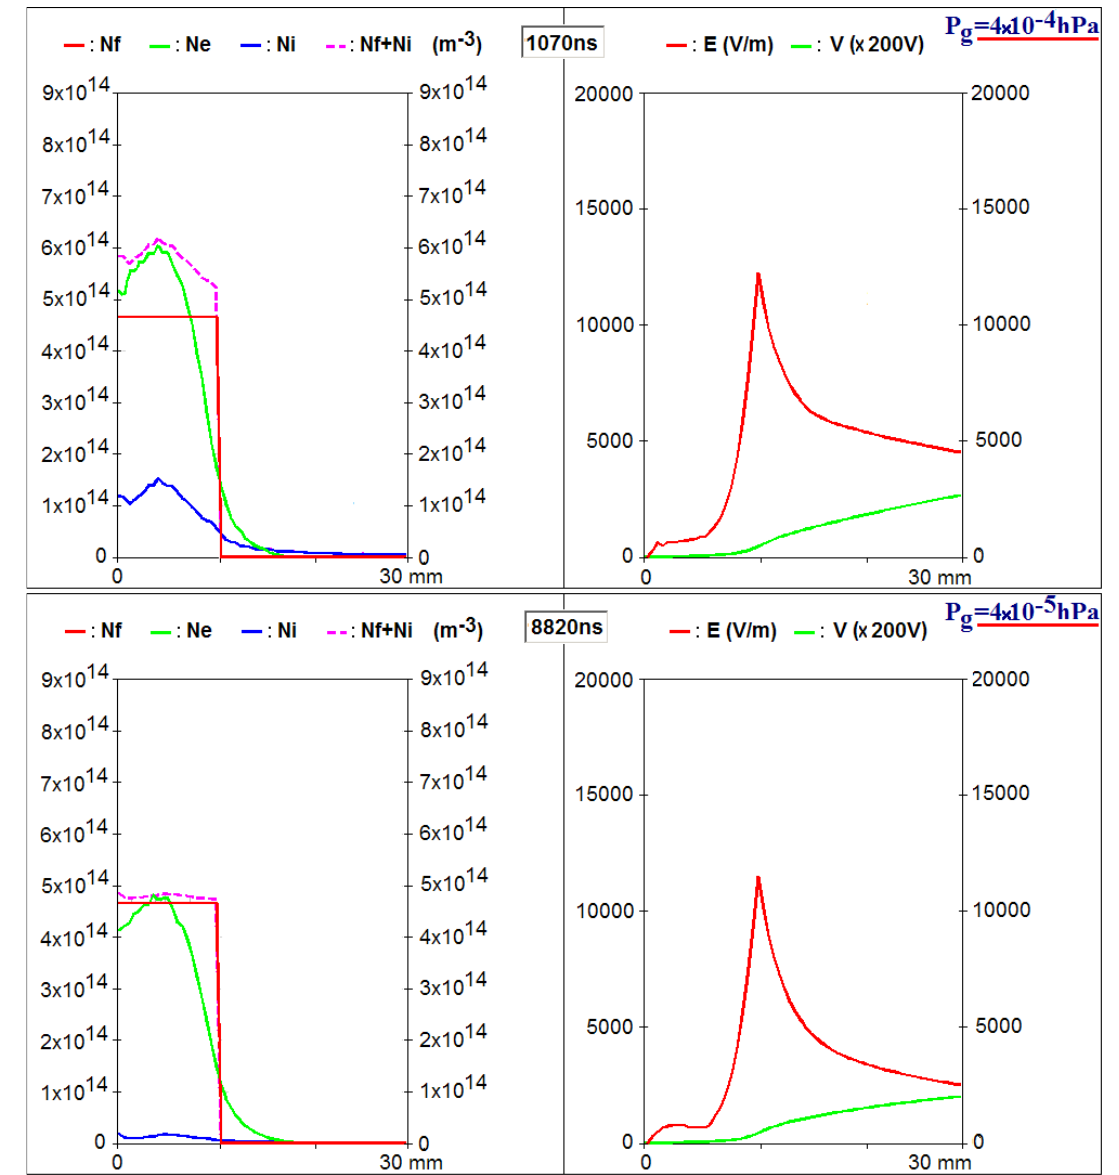
FIG. 4. (Color) Plasma and SC evolution of an H (cid:1) beam at 4 (cid:7) 10 (cid:2) 4 hPa (top) and 4 (cid:7) 10 (cid:2) 5 hPa